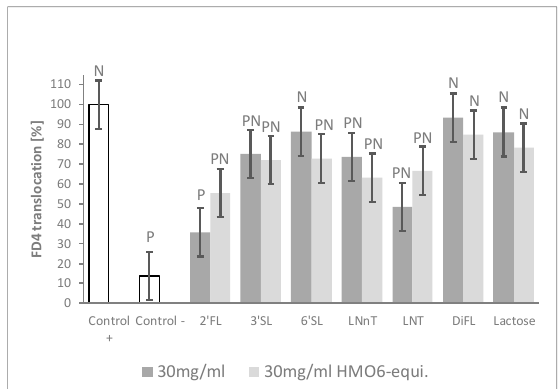
Figure 3. 2 ′ FL shows the highest barrier protection efficacy among individual HMOs. FD4 translocation with single HMO or lactose at both 30mg/mL HMO6-equivalent dose and at 30mg/mL. Controls were non-HMO treated cells and cytokine unchallenged cells (Control –) and non-HMO treated cells, but cytokine challenged (Control +). Means ± 0.5 x LSD5% are presented, so that two conditions are significantly different if their error bars do not overlap. Significant differences vs. controls are highlighted (P = different from Control +, N = different from Control − ). 2 ′ FL: 2 ′ Fucosyllactose; 3 ′ SL: 3 ′ Sialyllactose; 6 ′ SL: 6 ′ Sialyllactose; DFL: Difucosyllactose; FD4: 4 KDa FITC- Dextran; LNnT: Lacto-N-neotetraose; LNT: Lacto-N-tetraose; LSD 5% : Fisher’s least significant difference with α = 5%.